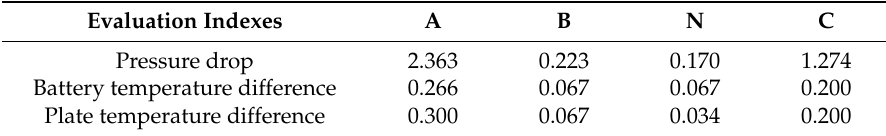
Table 7. The range values of the evaluation